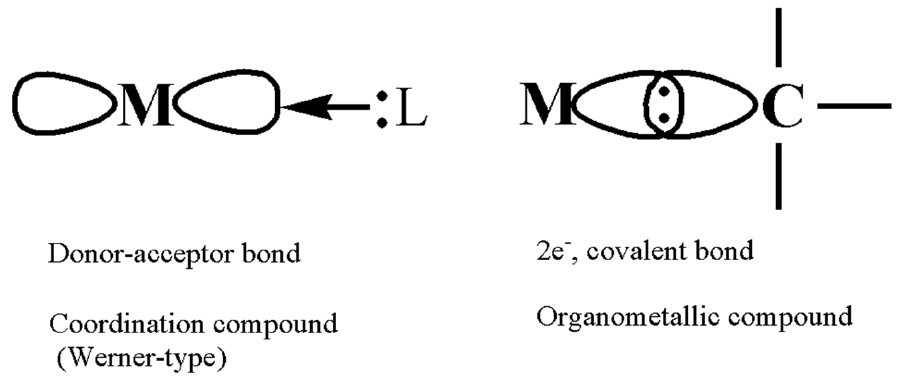
Figure 4. Simplified types of bonding found in coordination and organometallic compounds.